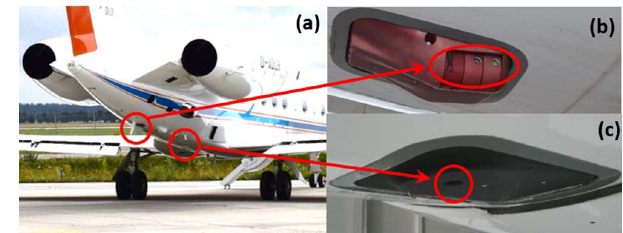
Figure 7. (a) Optical inlets of mini-DOAS (b) and SMART (c) mounted at the lower aircraft fuselage.